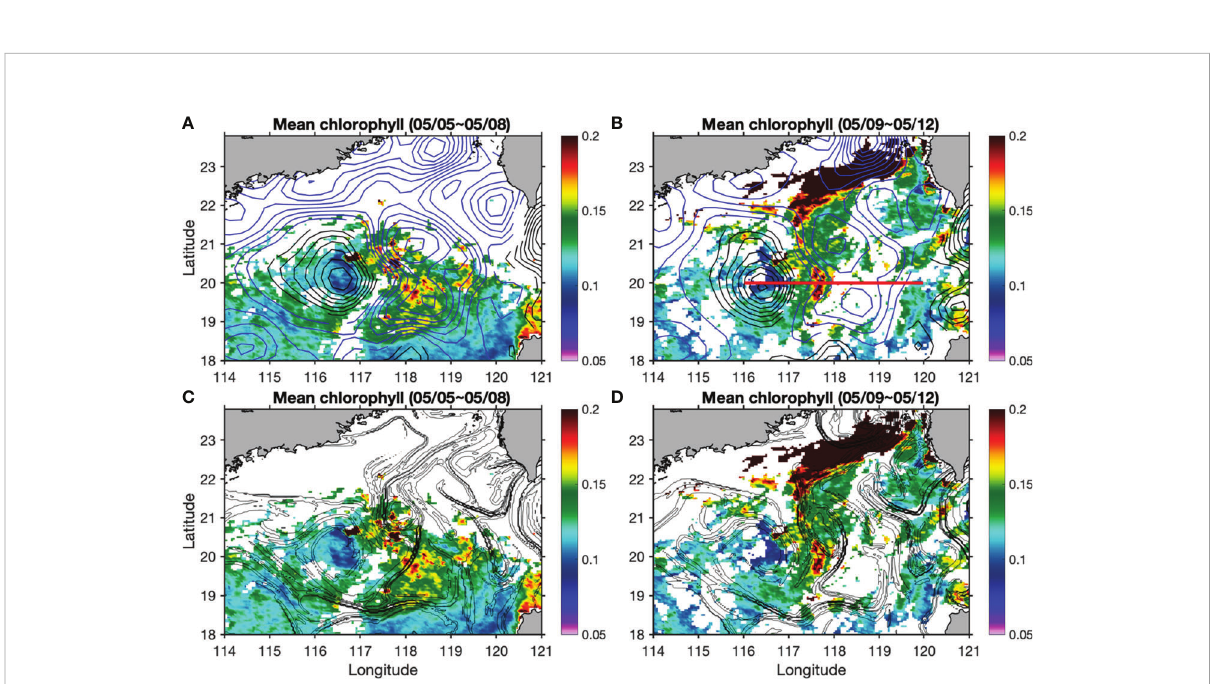
FIGURE 2 Surface chlorophyll concentration (units: mg m -3 ) overlaid by SLA (units: m; black contours for positive and blue ones for negative values) in (A, B) , and overlaid by FSLE contours larger than 0.1 d -1 in (C, D) during 5-12 May. The red line in (B) denotes the position of the transect for further